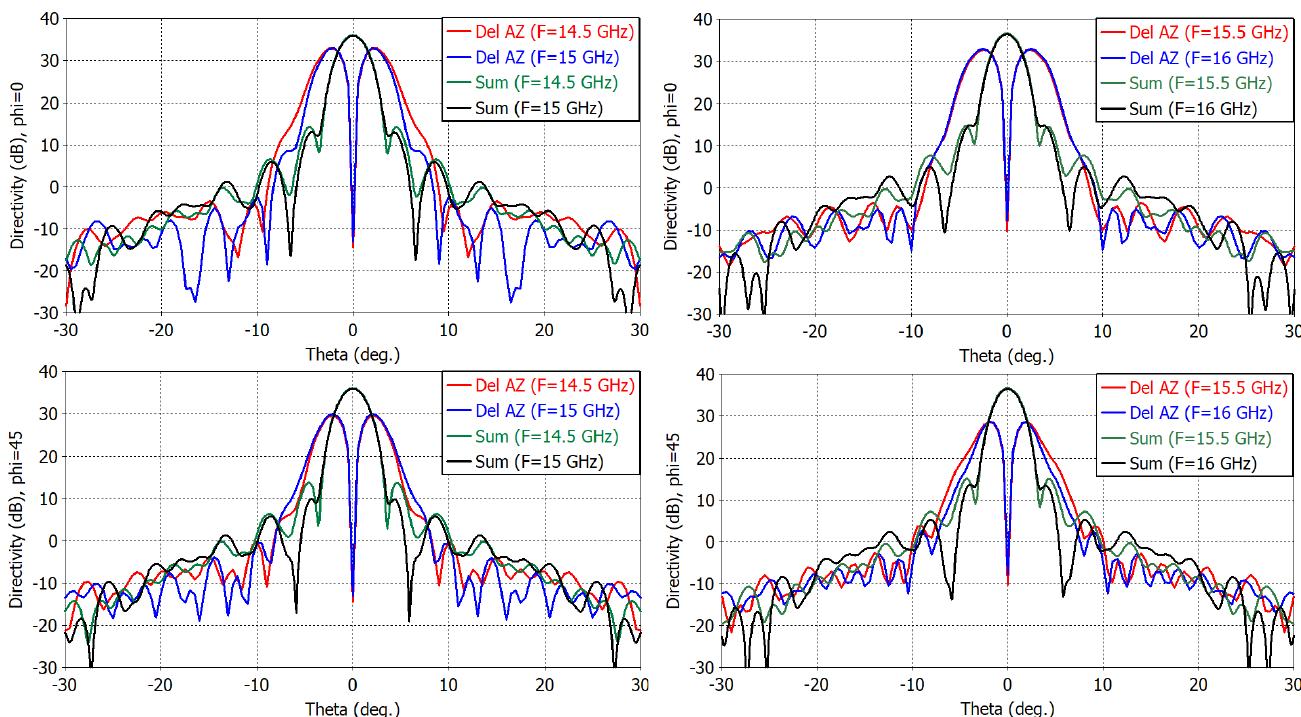
Figure 18. Directivity patterns of the reflector over ±30° angles.